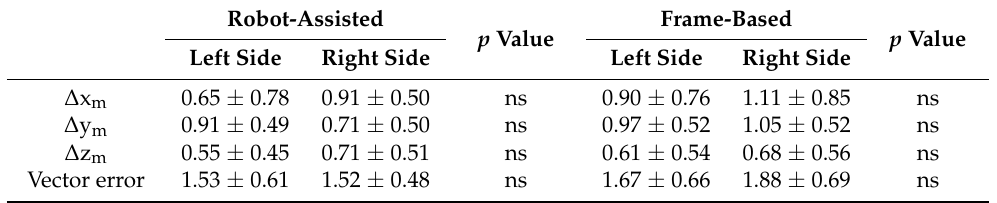
Table 2. Comparisons of deviations and vector error on the left and the right side (mm) in two groups. Robot-Assisted p Value